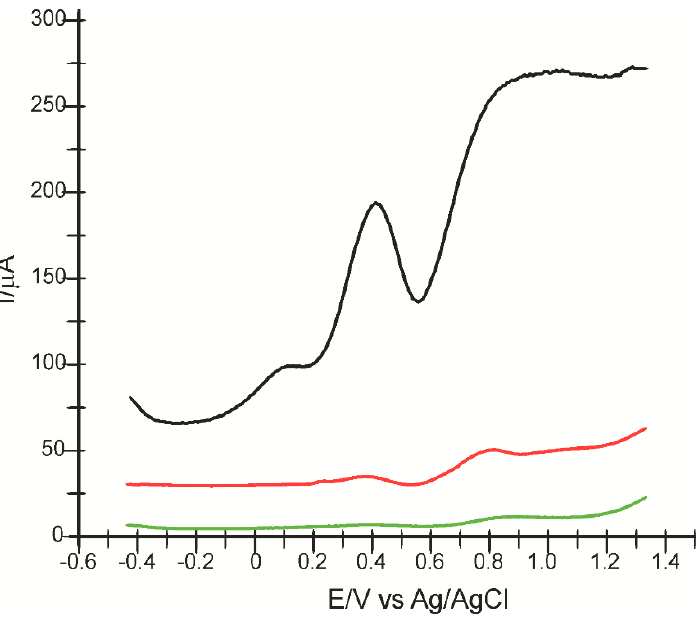
Figure 7. Square wave voltammograms obtained for CNF/SPE (black line), CNF-CoPc/SPE (red line), and CNF-CoPc-Lac/SPE (green line) by immersion in p-coumaric acid solution 10 − 3 M (PBS electrolyte 0.1 M pH = 5.0). The potential range is between − 0.4 and +1.3 V, impulse height 0.09 V, potential increase 7 mV at a frequency of 15 Hz.